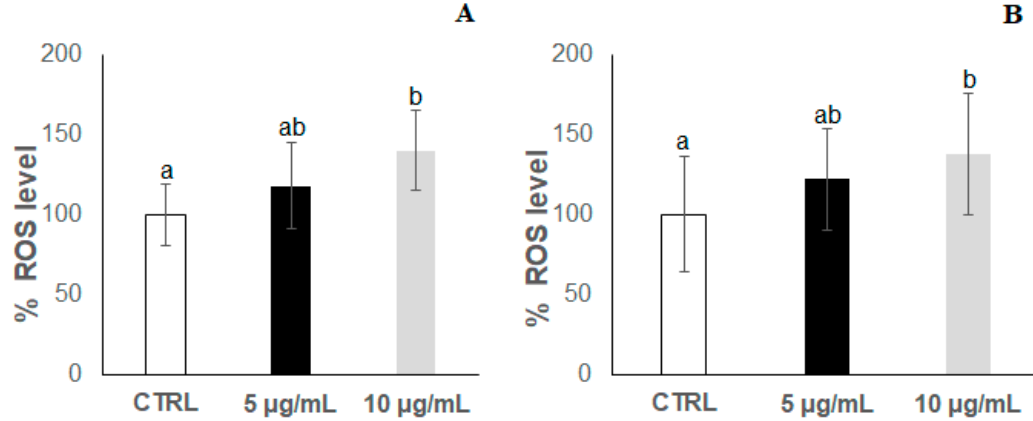
Figure 3. Reactive oxygen species (ROS) accumulation (expressed as percentage of fluorescence relative to controls) at the 2nd day of adulthood in C. elegans wild-type N2 strain grown in the absence (controls) and presence of the bilberry anthocyanin extract at concentrations of 5 and 10 µ g / mL in the culture medium. Results obtained in ( A ) non-stressed worms and ( B ) worms subjected to thermal stress (35 ◦ C, 2 h). In all cases, the assays were carried out in triplicate. The results are presented as the mean values ± SD. Di ff erent letters between bars indicate significant di ff erences, p < 0.05.